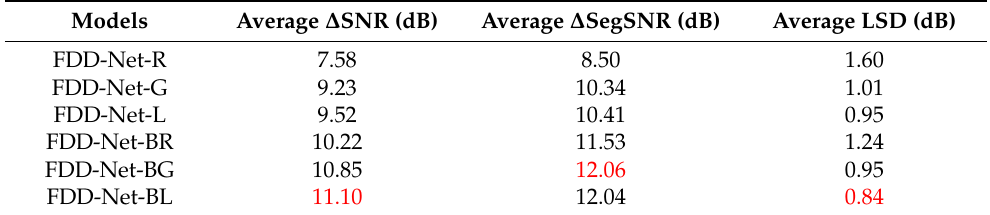
Table 3. Comparison with FDD-Nets using different recurrent layers. The red numbers were the best results of the corresponding